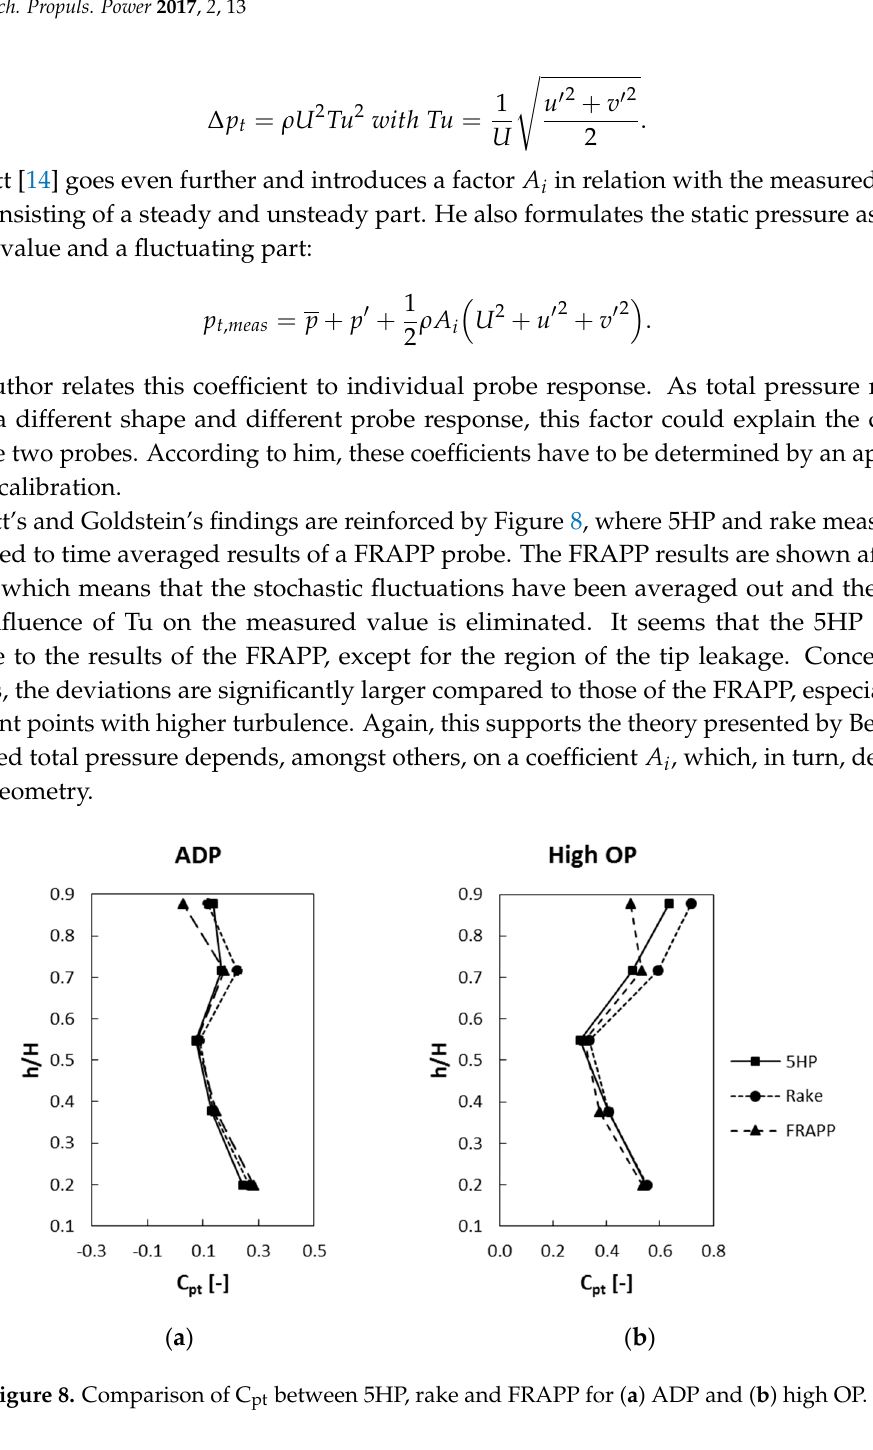
TU= 5% TU= 15% TU= 20%